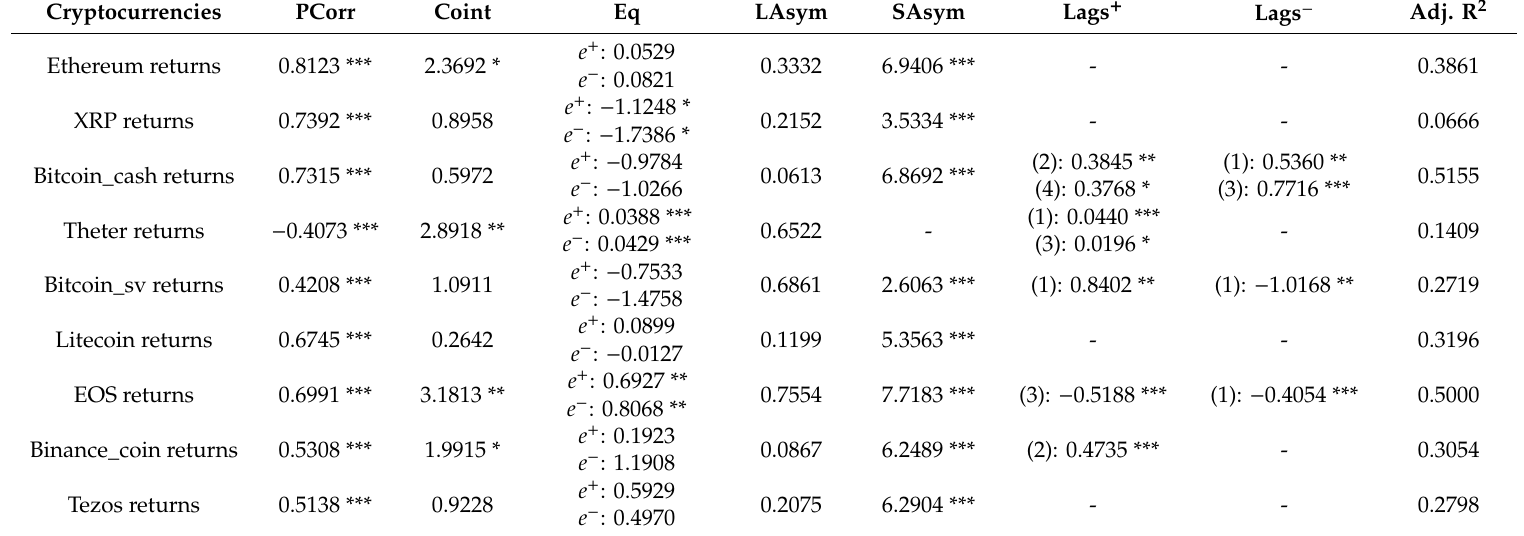
Table 4. Regression results of nonlinear ARDL models: asymmetry and cointegration tests between Bitcoin returns and the rest of relevant cryptocurrencies’ returns: weekly frequency.